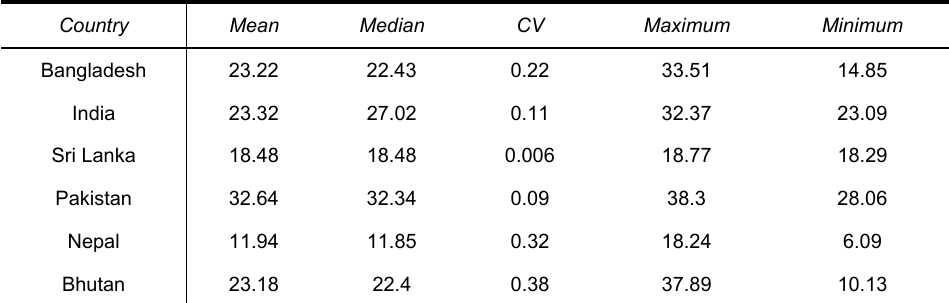
Table 2: Descriptive Statistics of Urban population (% of total) in South Asia Country Mean Median CV